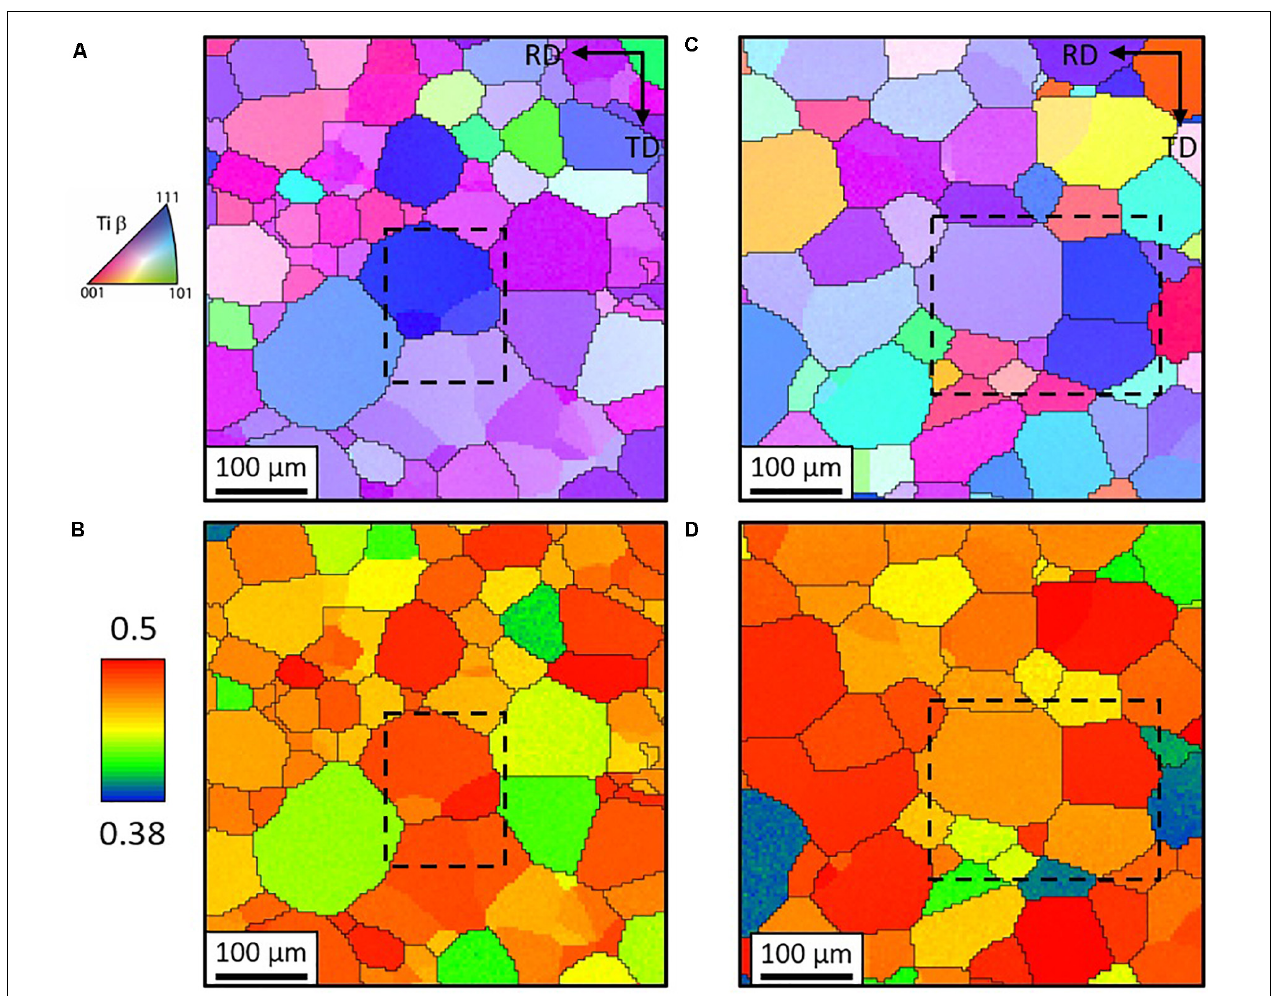
FIGURE 3 | Electron backscatter diffraction maps of initial microstructures before deformation of (A,B) Ti–12Mo and (C,D) Ti–8.5Cr–1.5Sn. (A,C) inverse pole figure (IPF) along the normal direction (ND) and (B,D) Schmid factor maps for the {332} < 113 > system. Studied areas during in situ tensile tests are indicated by dashed lines.